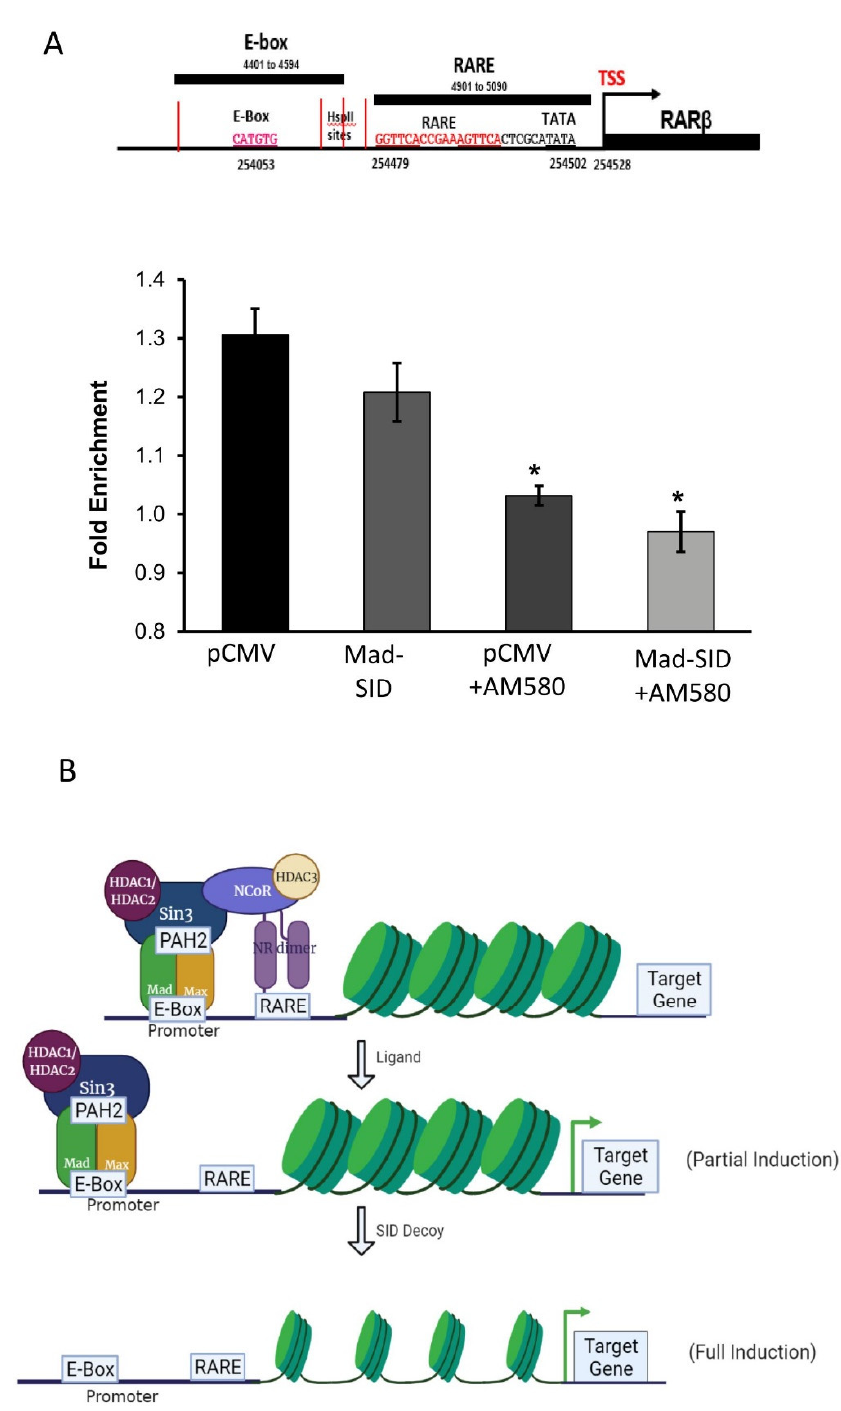
Figure 5. The RAR β expression is controlled by both MAD1 and RAR α : Chromatin immunopre- cipitation assays performed on AM580 treated pCMV and MAD-SID-overexpressing MDA-MB-231 show a reduction in the enrichment of NCoR at the RARE sequence and ( A ) a reduction of Sin3A and HDAC2 on the E-Box sequence of the RAR β promoter. ( B ) Schematics show the proposed model wherein treatment with either a ligand or SID partially recovers the de-repression of RAR β expression; however, a combination removes the entire complex, leading to complete de-repression of RAR β expression. The data presented are an average change in the fold enrichment obtained from two independent experiments. The statistical analysis was conducted using an unpaired ‘ t ’ test; error bars represent mean ± SD. * p <